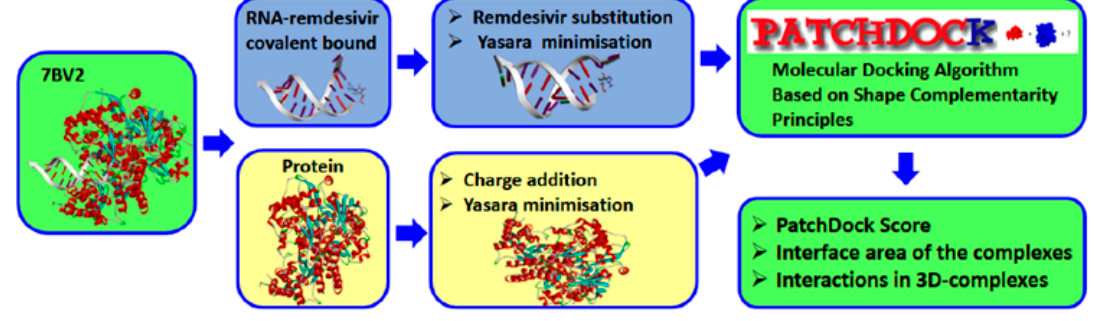
Figure 6. Workflow of the computational analysis.